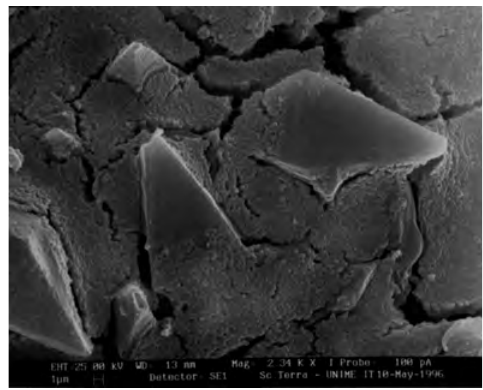
Fig. 5. Scanning electron microscope picture (2340x) of short rod bacteria and sulphur crystals grown from the C7 thermal water